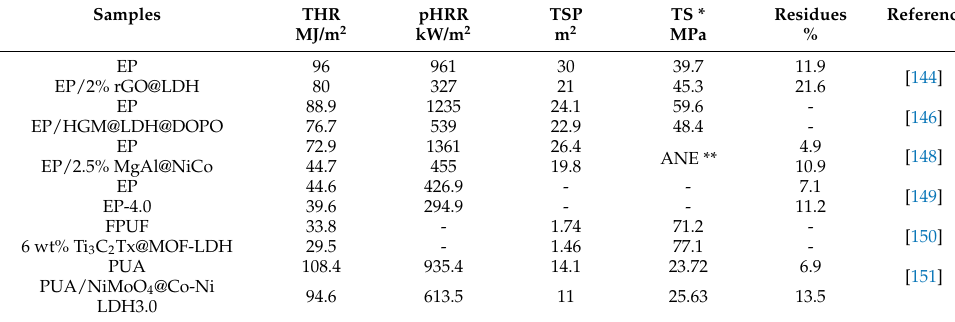
Table 4. Data on MOFs-derived LDHs as flame